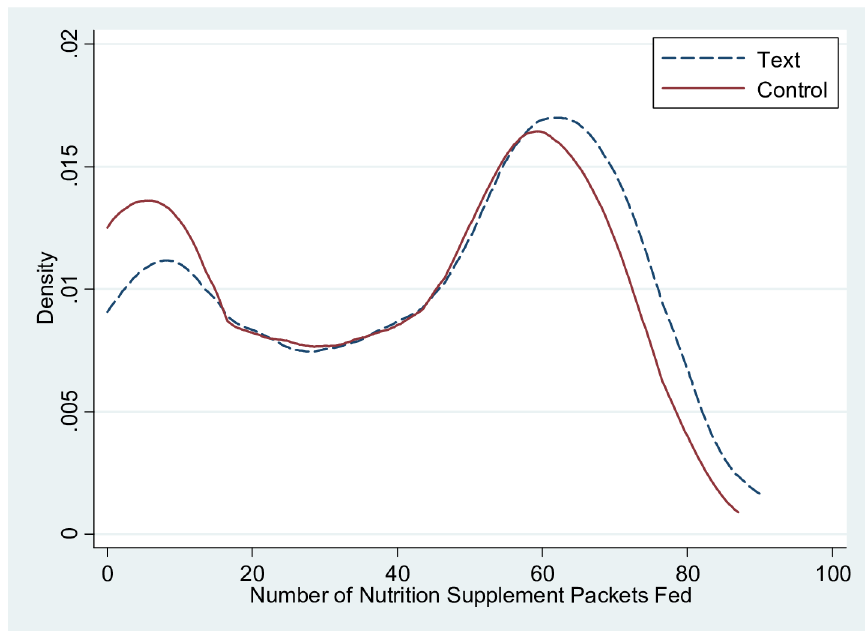
Fig 2. Density distribution curve of the number of MNP packets fed by trial arms: Rural Shaanxi Province, China.